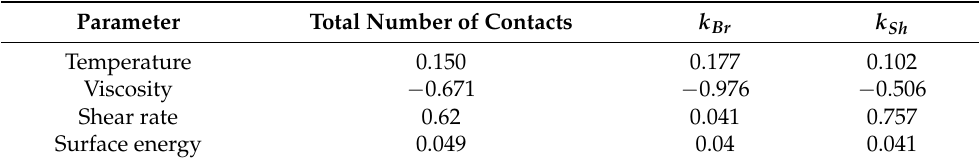
Table 4. Spearman correlation coefficients between the input ANN parameters (Table1) and the total number of detected contacts in DEM simulations, as well as the kernel coefficients estimated from the extracted collisions statistics. Parameter Total Number of